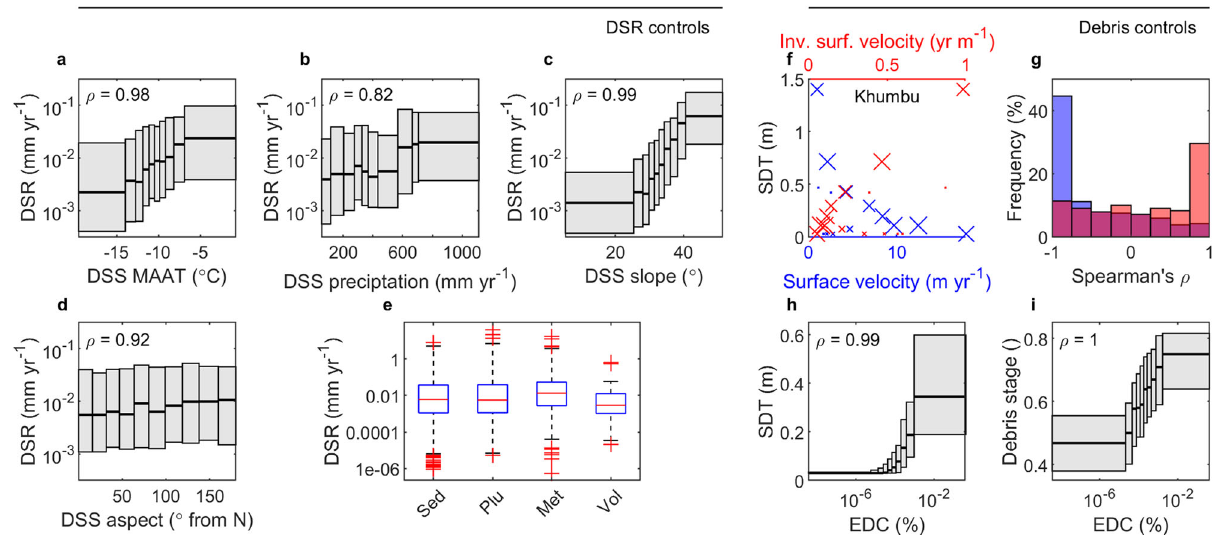
Fig. 3 Controls on debris-supply rate and supraglacial debris. Debris-supply-slope mean DSR binned by ( a ) mean annual air temperature (MAAT), ( b ) annual precipitation, ( c ) slope, ( d ) aspect and ( e ) rock type: sedimentary (Sed), plutonic (Plu), metamorphic (Met) and volcanic (Vol). f Supraglacial debris thickness (SDT) with respect to glacier surface velocity (blue) and inverse surface velocity (red) for Khumbu Glacier, where marker size indicates the number of data points. g Frequency distributions of Spearman ’ s ρ for debris thickness and glacier – surface velocity (blue) and debris thickness and inverse surface velocity (red) for glaciers with debris-covered area larger than 1 km 2 . h Glacier-mean debris thickness binned by englacial debris content (EDC). i Debris-cover stage binned by EDC. Plots with bins show median and interquartile range, where each bin contains one tenth of the data. Spearman ’ s ρ is calculated for bin centres. Boxplots show the median, 25th and 75th percentiles, and outliers, where outliers are data points that fall outside approximately ± 2.7 times the standard